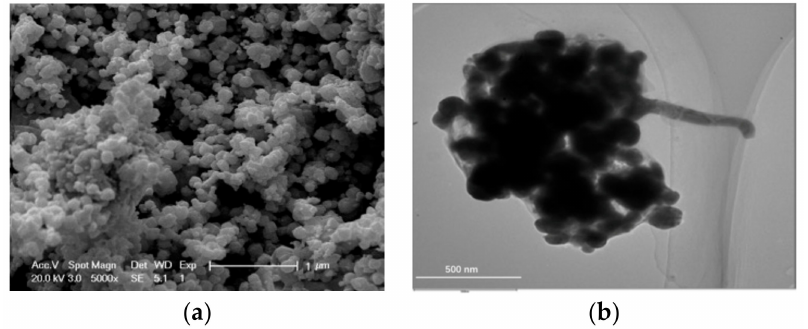
Figure 1. ( a ) SEM and ( b ) TEM images of Ag@Ag 2 O-G2 (with 2.5 wt%